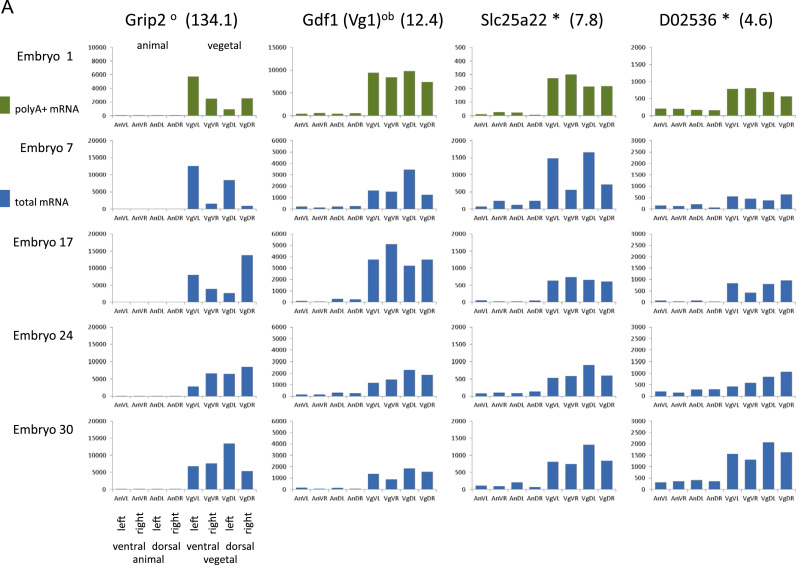
Examples of single blastomere sequencing data for 8-cell stage embryos. Each panel contains sequence data for five embryos. Green is from polyA+ SMARTer low-RNA libraries, blue are from total mRNA Ovation v2 libraries. Suffixes: *novel in this study, °previously found in oocyte data (Cuykendall and Houston, 2010), bpreviously found in blastomeres data (Grant et al., 2014). Figures in brackets are fold-changes in this study. A. Vegetal pole enrichment. B. Animal pole enrichment.